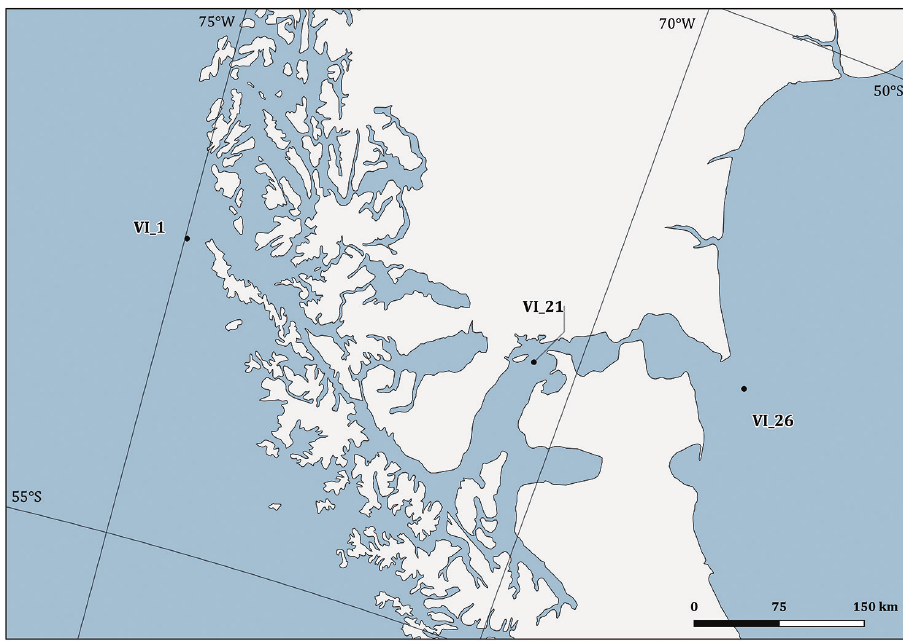
Figure 5. Detailed map of the sampling stations of the sixth PNRA expedition (Magellan Strait).